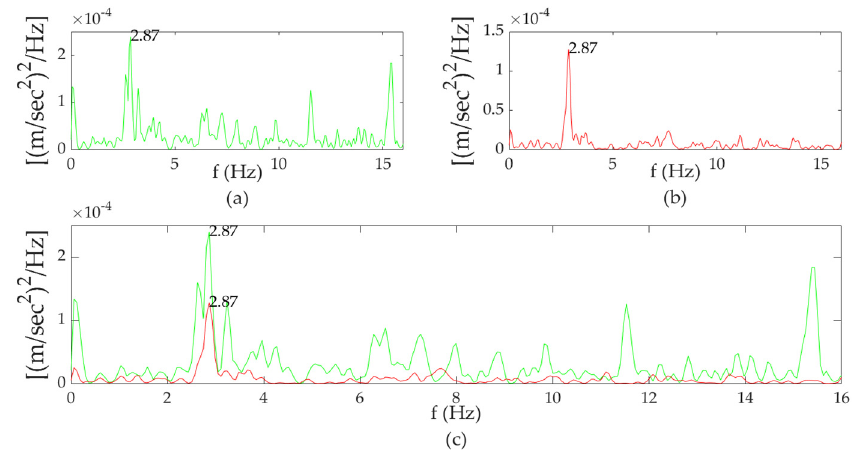
Figure 27. Single-sided Power Spectral Density of sensors 2 and 5: ( a ) sensor 2; ( b ) sensor 5; ( c ) sensor 2 vs. sensor 5.